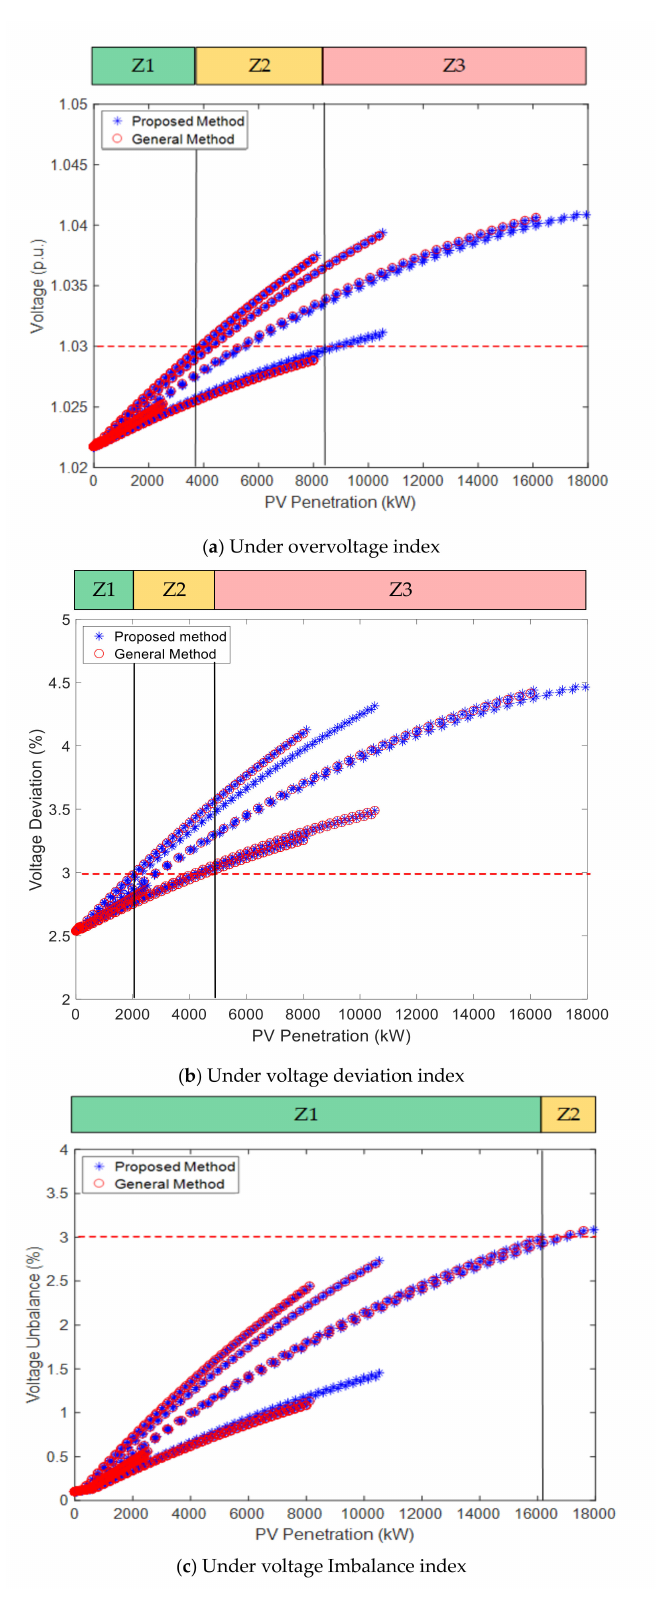
Figure 9. PVHC assessment results for Case